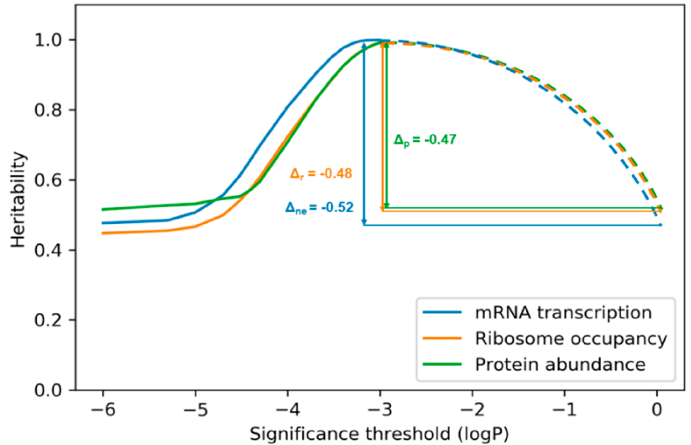
Figure 1. The heritability of mRNA transcription, ribosome occupancy, and protein abundance according to different significance thresholds of quantitative trait loci. ∆ ne , ∆ r , and ∆ p represent the differences between the maximum heritability and the heritability considering all the variants across the genome for mRNA transcription, ribosome occupancy, and protein abundance, respectively. Table 1. The characteristics at the minimum and maximum differences in heritability between mRNA transcription and protein abundance, explained by expression quantitative trait loci (eQTLs).